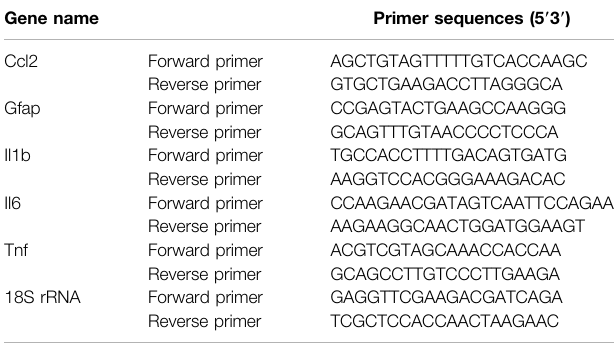
Frontiers in Pharmacology |